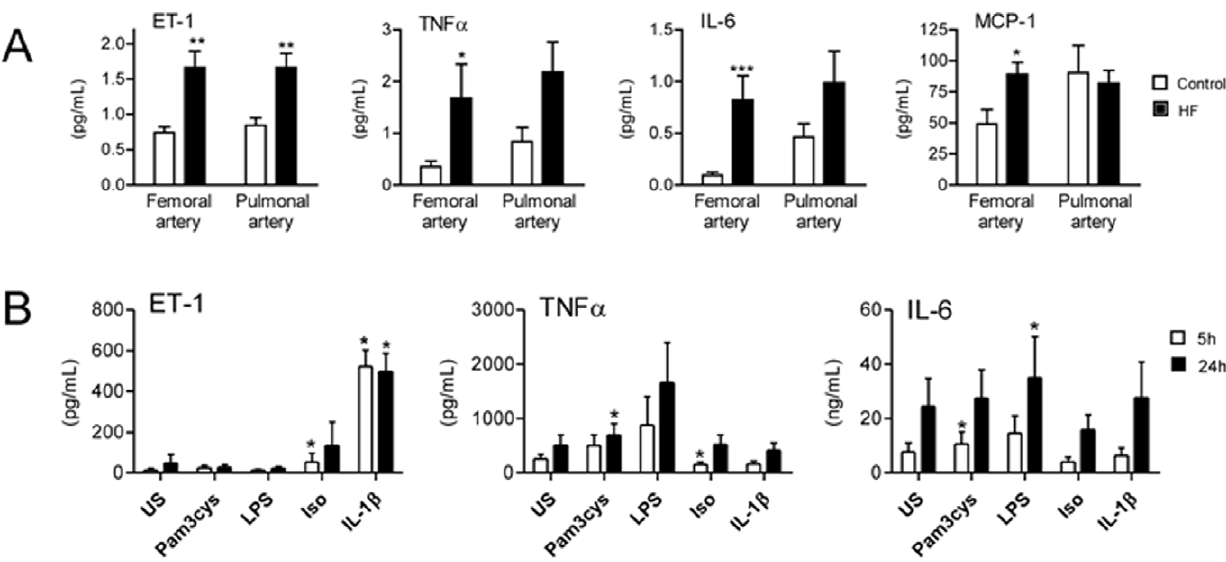
Figure 2. Levels of inflammatory mediators in pulmonary and femoral artery and after stimulation of alveolar macrophages. A. Plasma levels of ET-1, TNF a , IL-6 and MCP-1 in femoral and pulmonary artery in HF patients ( n =15) and controls ( n =10). Plasma levels of the various cytokines were measured by EIA. B. Release of ET-1, TNF a and IL-6 in alveolar macrophages from healthy controls ( n =5) that were cultured for 5 and 24 hours (h) with or without LPS (100 ng/mL), Pam 3 Cys (1 m g/mL), isoproterenol (20 m M) and IL-1 b (5 ng/mL). Cytokine levels in supernatants were measured by EIA. Data are mean 6 SEM. *p , 0.05, **p , 0.01 and ***p , 0.001 versus controls or unstimulated (US) cell, respectively.